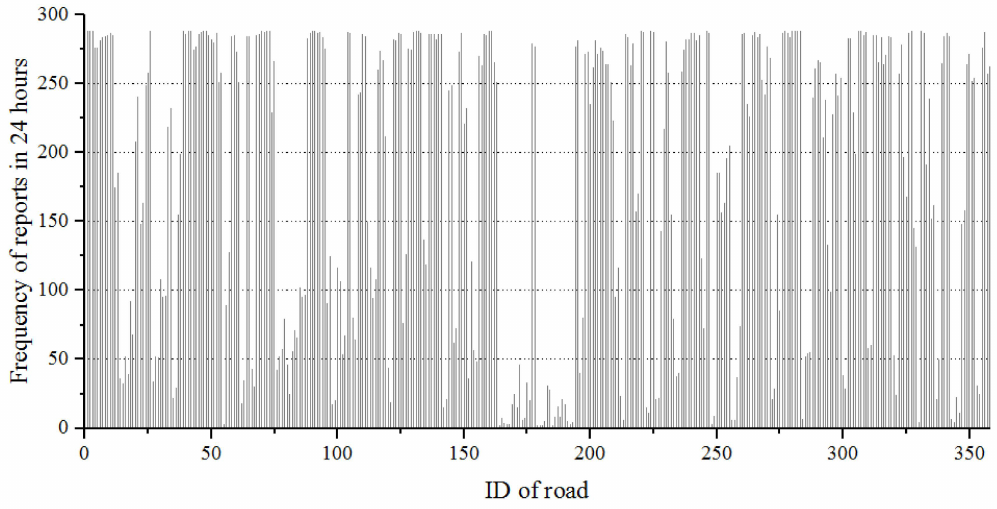
Figure 1. Frequency of reports from the 358 monitored roads in a one-day period (from 20:20, 14 October 2015 to 20:15, 15 October